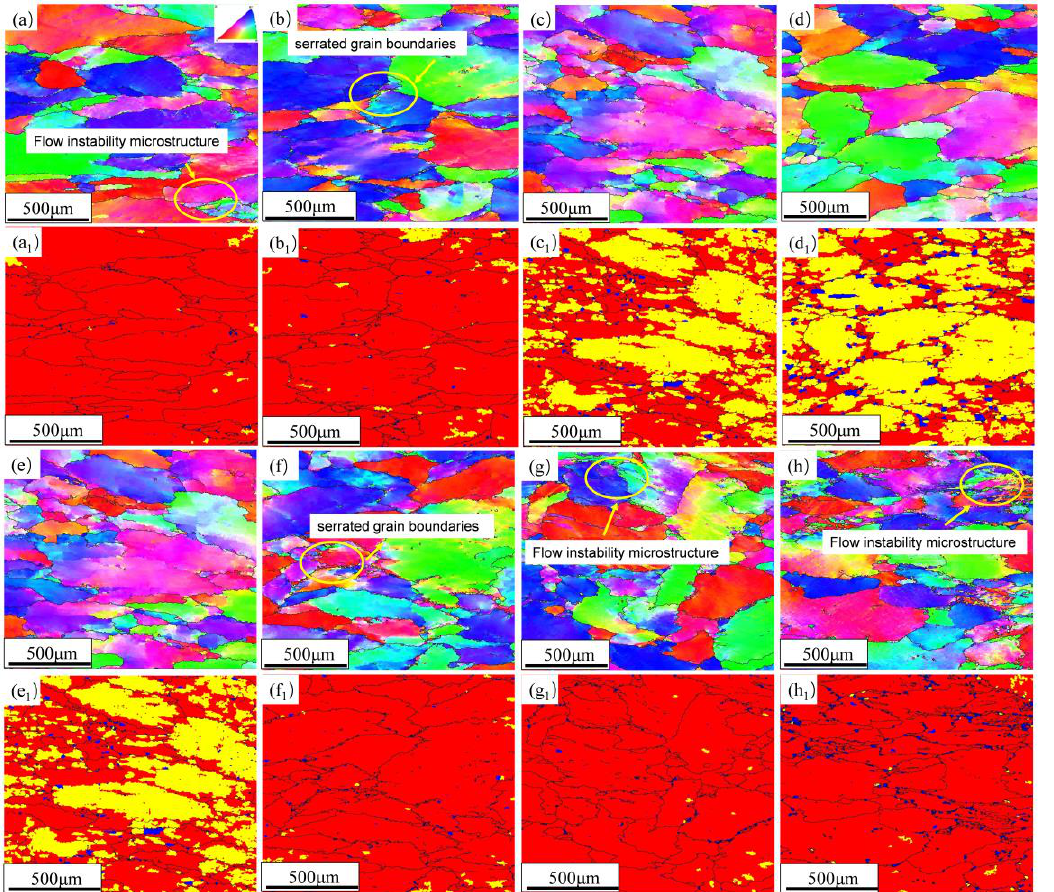
Figure 7. EBSD diagram and recrystallization diagram of the alloy under different deformation con- ditions: ( a )( a 1 ) 350 °C/0.01 s − 1 ; ( b )( b 1 ) 400 °C/0.01 s − 1 ; ( c )( c 1 ) 450 °C/0.01 s − 1 ; ( d )( d 1 ) 500 °C/0.01 s − 1 ;